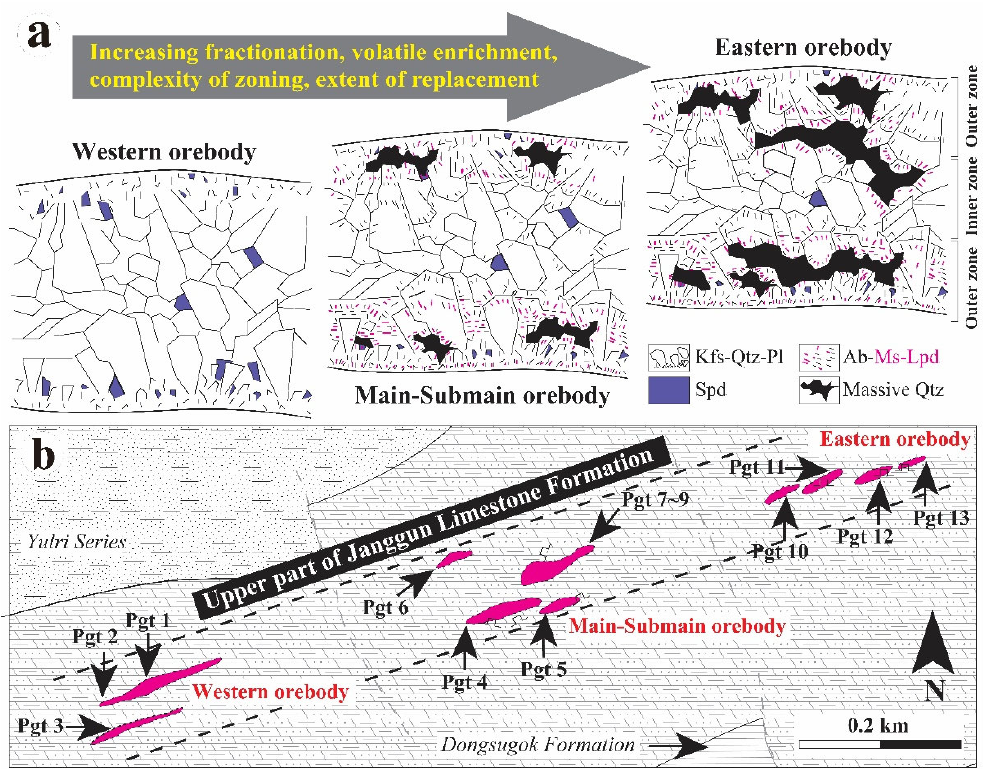
Figure 13. Schematic illustrations of rare ‐ element pegmatite (REP). ( a ) Internal zoning (modified from [25]). The black dotted line is albite and the purple dotted line is muscovite or lepidolite. Note the inner (K ‐ feldspar ± quartz) zone and outer (plagioclase ‐ mica ‐ quartz ± K ‐ feldspar) zone. ( b ) Distribution of REPs in the Boam deposit. The black dotted line indicates the area with a high potential for mineral exploitation. See Figures 2 and 3 for abbreviation definitions.